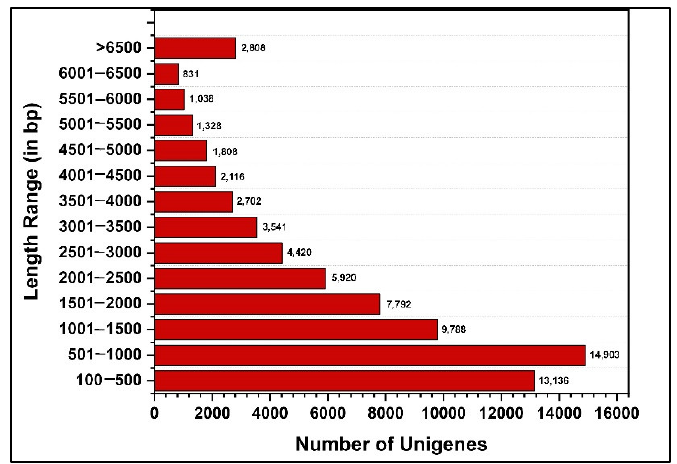
Figure 1. Bar graph showing the differential length distribution of assembled unigenes from the transcriptome. This figure was plotted with number of unigenes as x axis against the length of each unigene as y axis. Table 1. De Novo Transcriptome Assembly statistics of P. bremeri transcripts and de novo assembled transcripts completeness assessment results using BUSCO